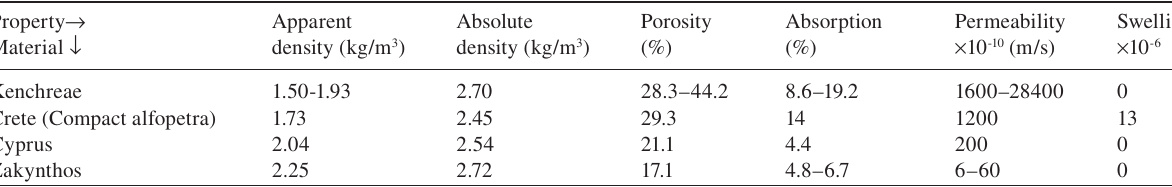
Table 2 Physical properties of the Kenchreae stone and its possible